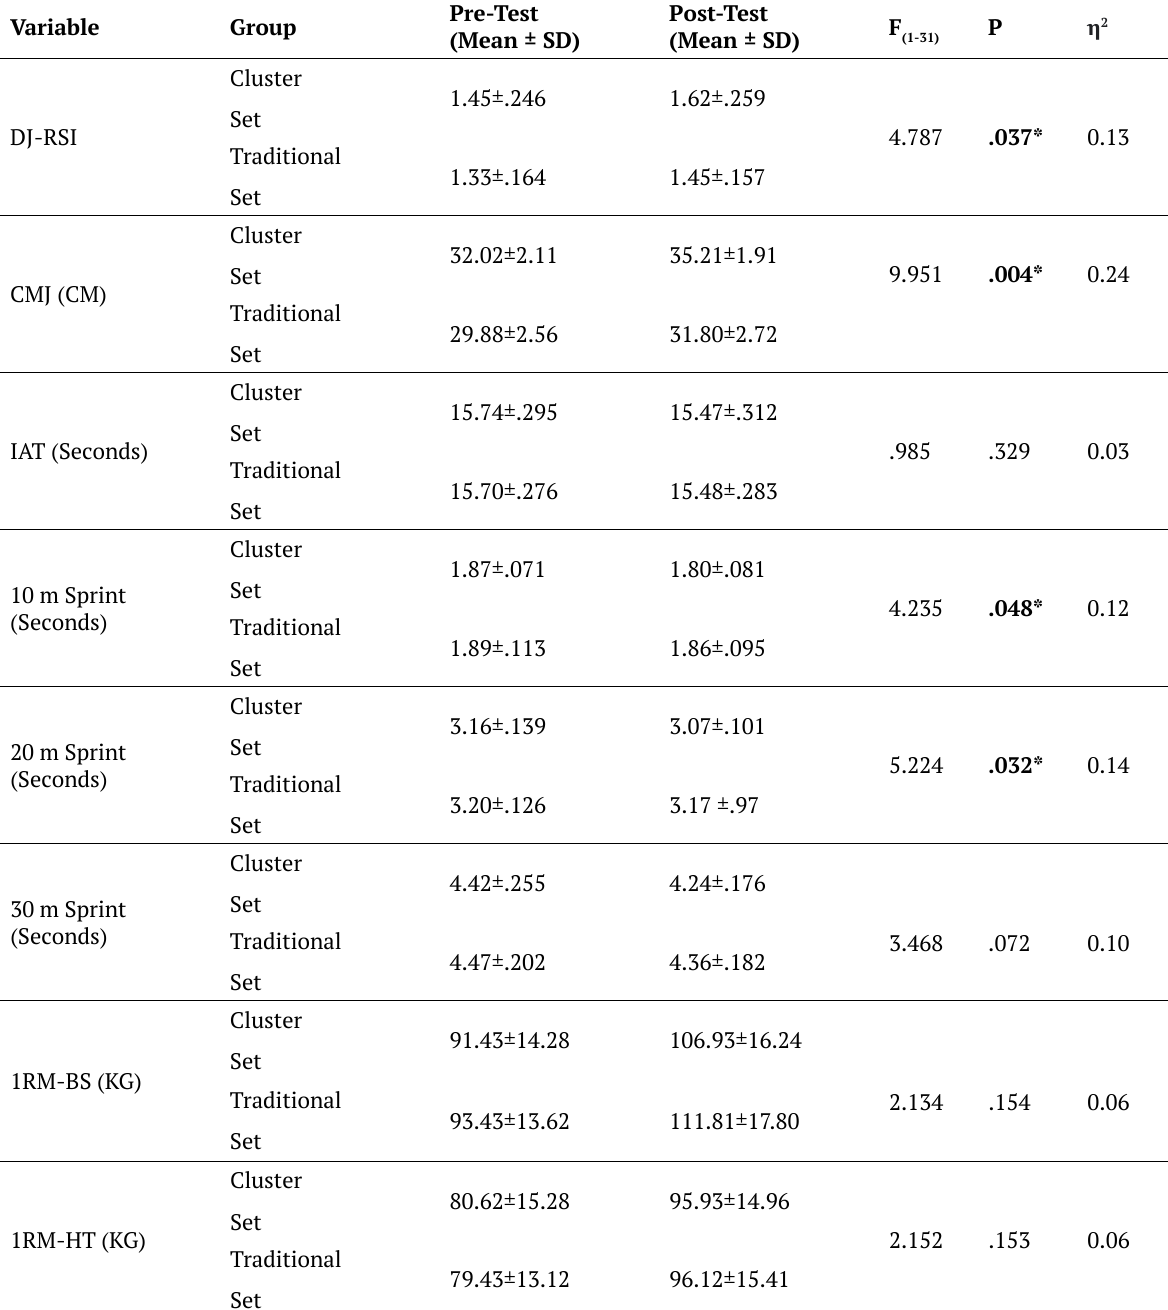
Table 4. Repeated Measures Anova Results Regarding The Difference Between RSI, CMJ, IAT, Speed And Maximal Strength Values Between